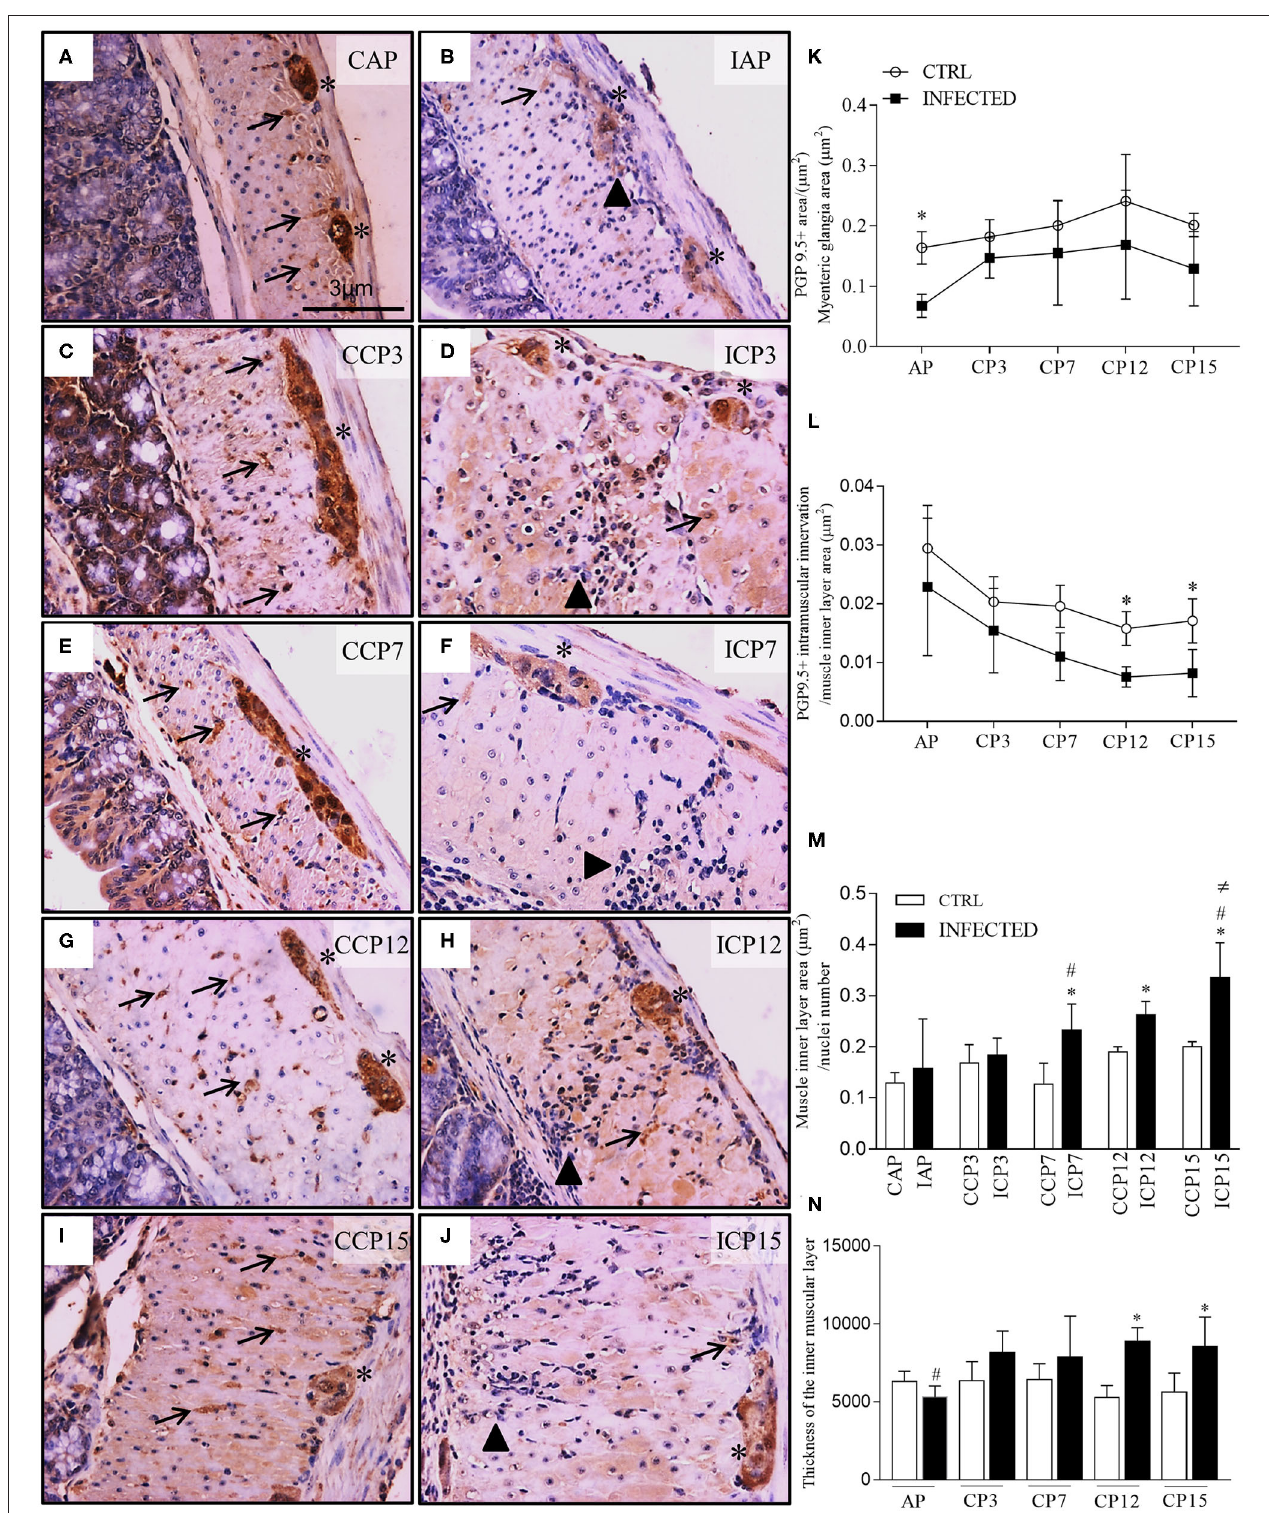
FIGURE 2 | Ganglionic neuronal damage, intramuscular denervation, and phenotype changes of intestinal muscular propria during megacolon development. (A–J) ganglia and intestinal muscle layer of Swiss mice infected with 50,000 T. cruzi strain Y trypomastigotes obtained from animals at the acute (CAP, controls; IAP,